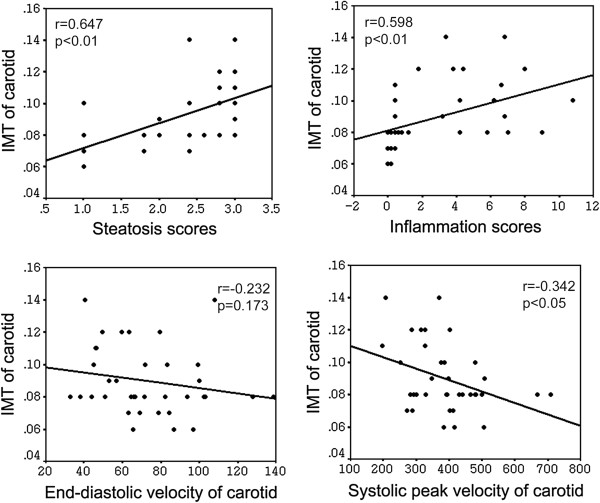
Correlations between ultrasound analyses and the histological diagnosis. Scatter plots of the IMT of the carotid artery and the steatosis scores of the liver, the inflammation scores of the liver, the end-diastolic velocity and the systolic peak velocity of the carotid artery in rats. Spearman rank test was performed to determine the correlations (r).